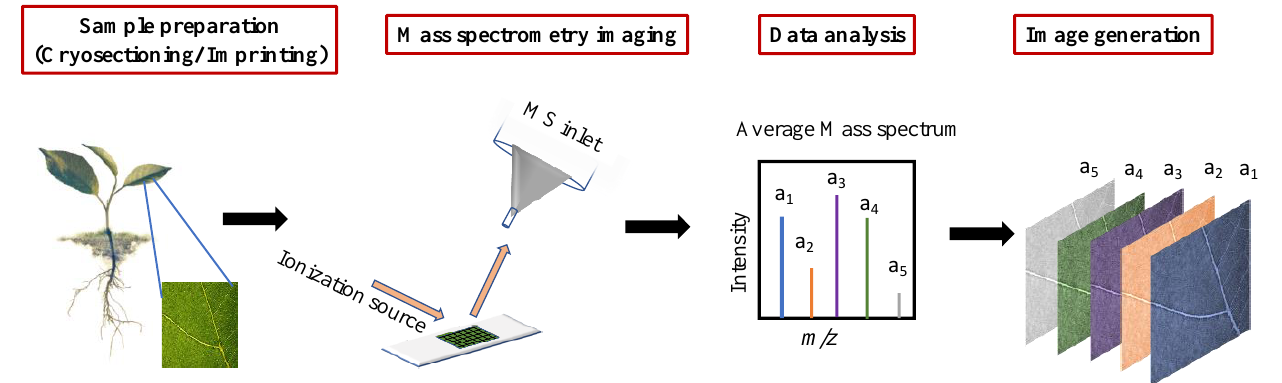
Figure 1. General workflow in an MSI experiment of plant tissues. A suitable sample (for example, a leaf section) from a plant is collected and prepared. With the aid of MS instruments such as MALDI, DESI, SIMS and LAESI with varying ionisation sources, the surface can be mapped for the constituent chemicals. The mass spectra obtained from each point in the sample along with the positional information can be used to create several ion images showing localisation for numerous chemicals of interest from a single scan.